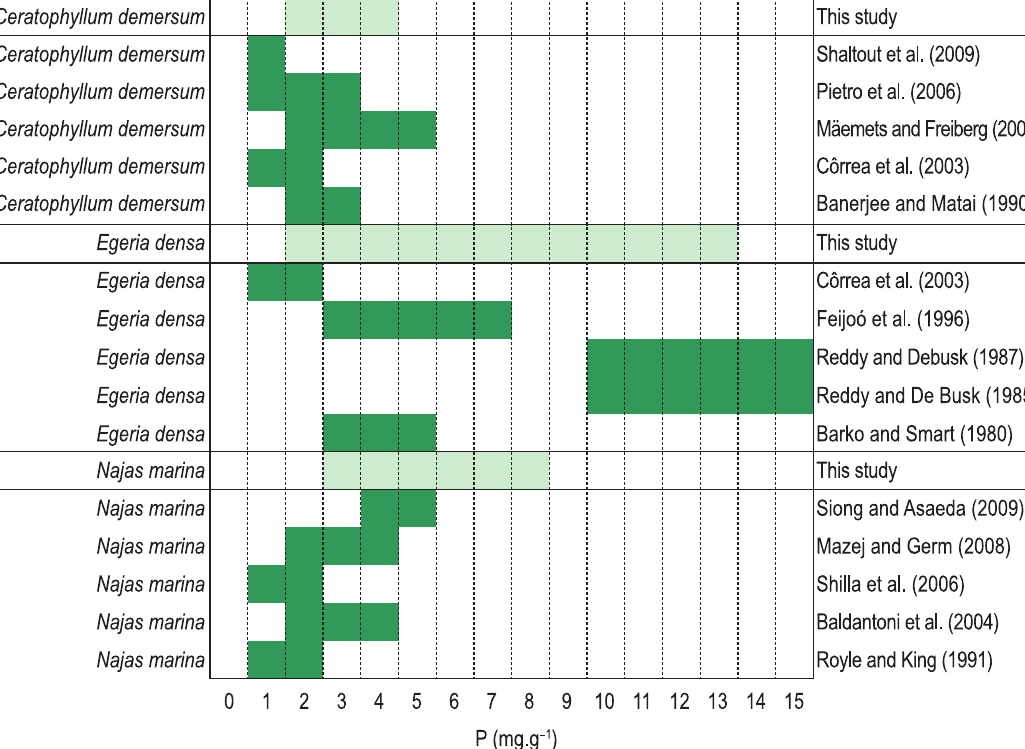
Figure 8. Phosphorus content in macrophytes, expressed as milligram per gram of dry matter (mg.g -1 ), using data from this study and from